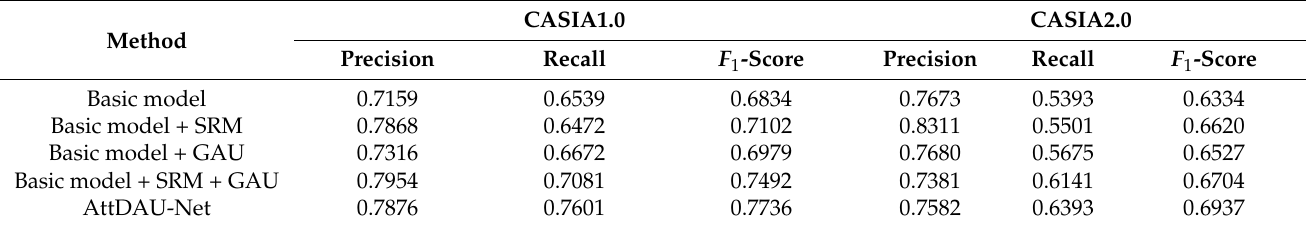
Table 2. Comparative results by removing different components from the basic model.